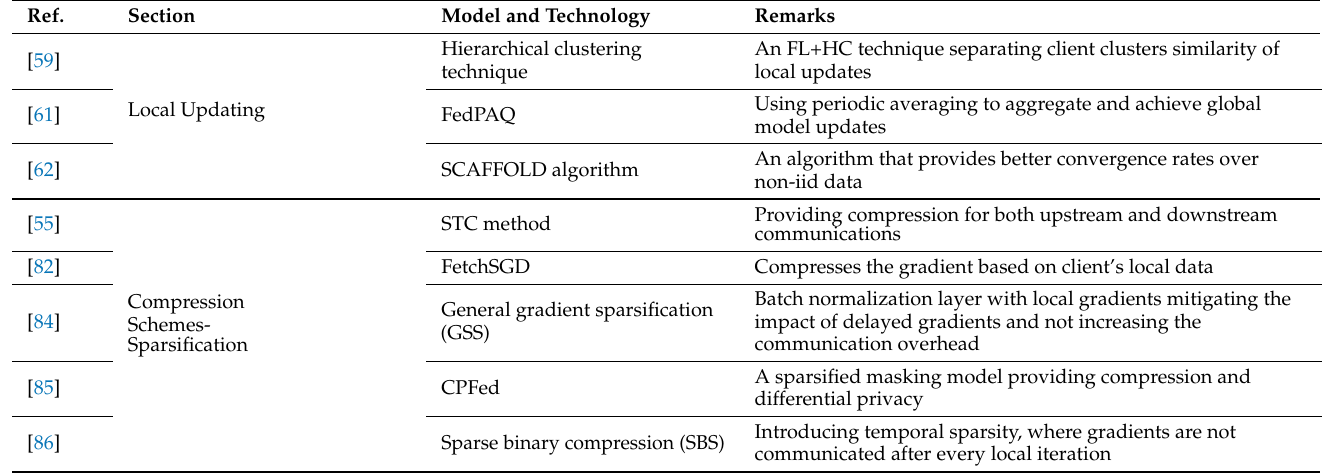
Table 2. Research conducted towards reducing the overall communication costs and overheads in an